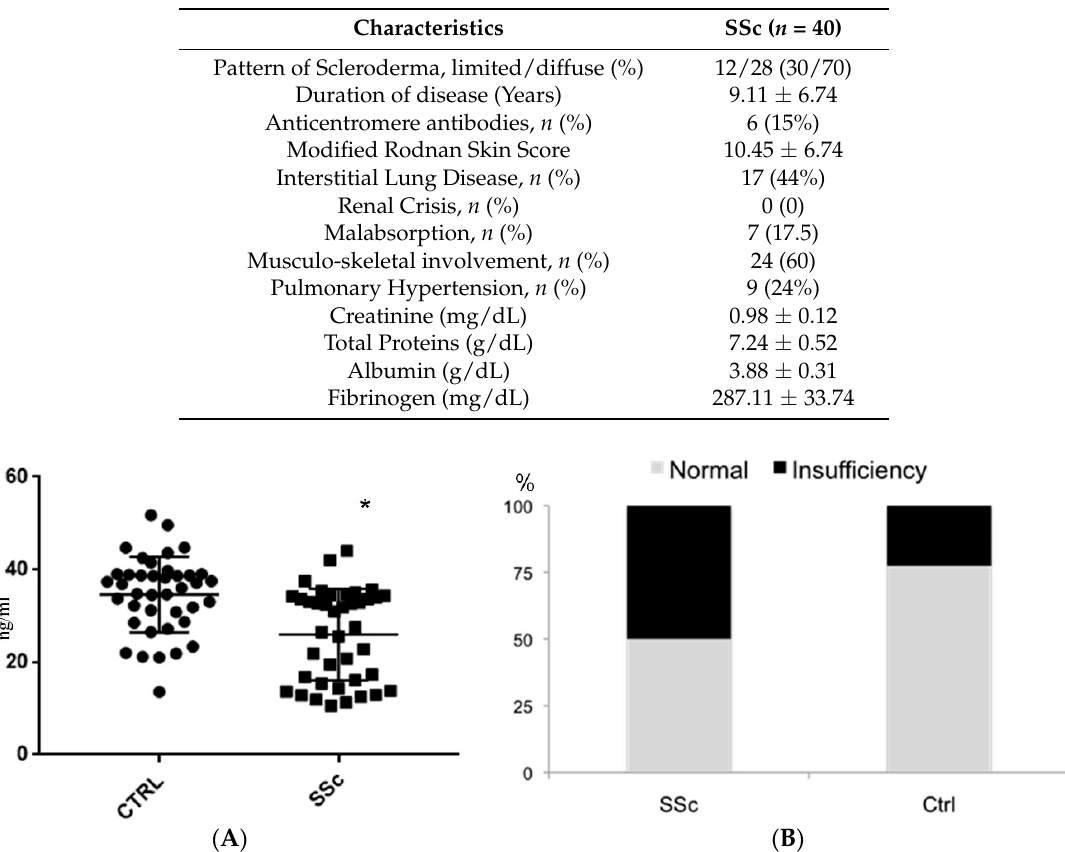
Figure 1. ( A ) The 25(OH)D 3 serum levels in systemic sclerosis and control groups. * p = 0.0003; ( B ) Prevalence of 25(OH)D 3 insufficiency in systemic sclerosis and control groups. p = 0.02.